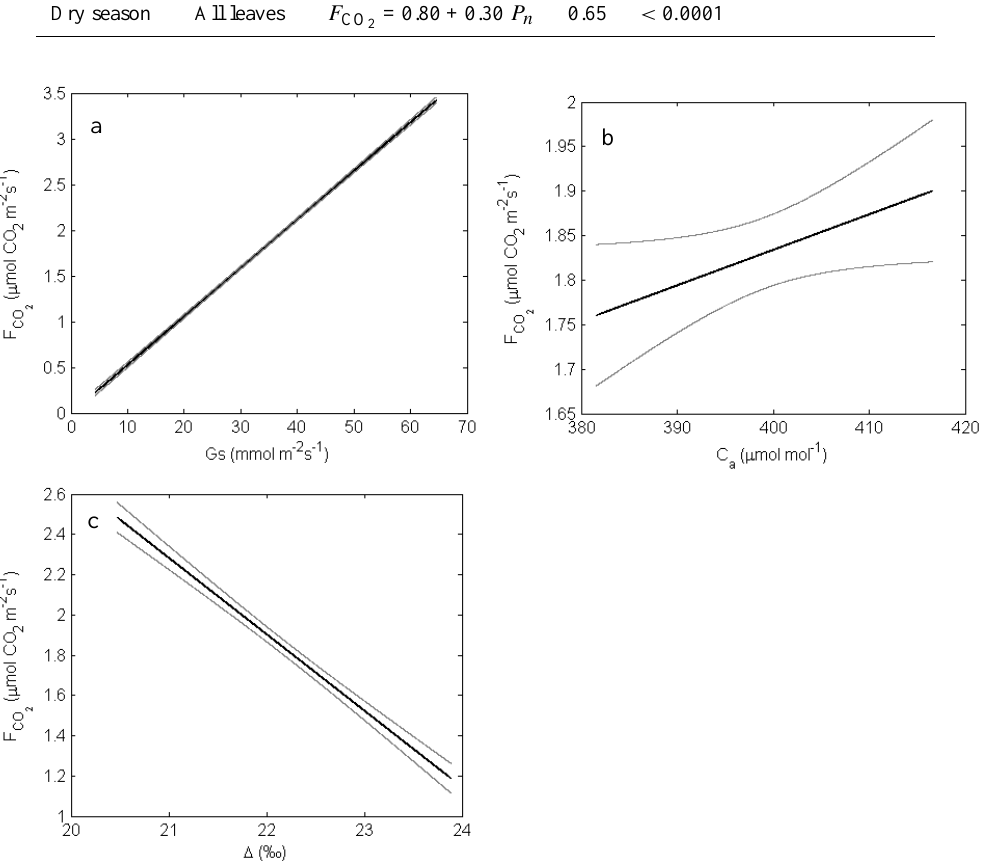
Fig. 7 Canopy CO 2 uptake rate ( F CO2 ) sensitivity analysis. The bold black lines are the regression 1095 Fig. 7. Canopy CO 2 uptake rate ( F CO ) sensitivity analysis. The bold black lines are the regression relationships and the thin gray lines are the 2 relationships and the gray thin lines are the 95% confidence intervals for the data. (a) Relationship 1096 95% confidence intervals for the data. (a) Relationship between canopy stomatal conductance ( G s ) and F CO R 2 = 0 . 8263, p < 0 . 0001). (b) Relationship between ambient CO 2 concentrations ( C a ) and F CO between canopy stomatal conductance ( G s ) and F CO2 ( F CO2 = 0.0531 G s – 0.002, R 2 = 0.8263, p < 1097 p = 0 . 0001). (c) Relationship between photosynthetic 13 C discrimination ( 1) and F CO 0.0001). (b) Relationship between ambient CO 2 concentrations (C a ) and F CO2 ( F CO2 = 0.004C a + 0.239, 1098 p < 0 . 0001). Data were obtained by the SF/SI R 2 = 0.0016, p = 0.0001). (c) Relationship between photosynthetic 13 C discrimination (Δ) and F CO2 1099